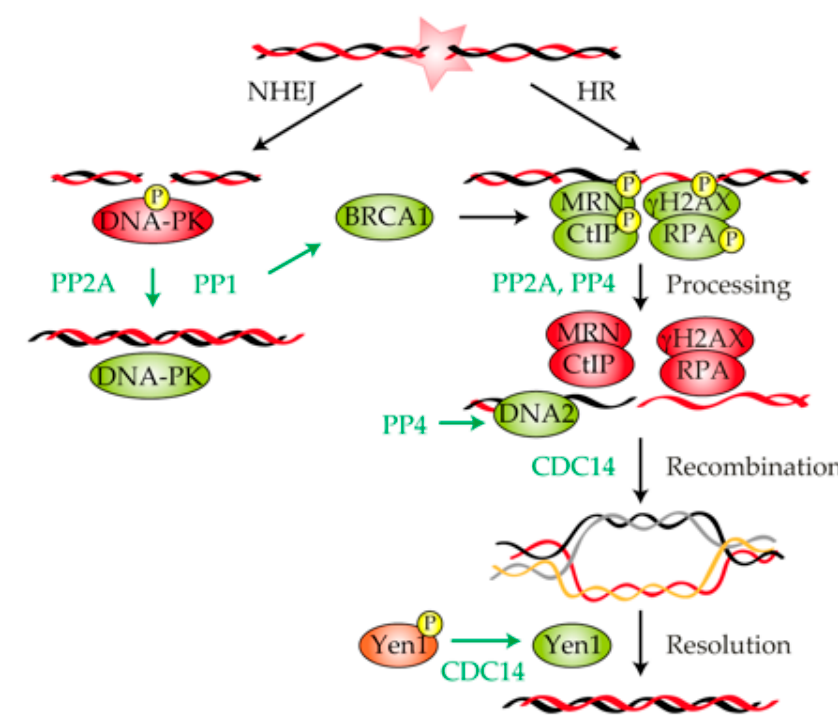
Figure 2. Involvement of protein phosphatases in the repair of a DNA lesion. Schematic representation showing the repair of a double-strand break (DSB) by non-homologous end joining (NHEJ) and homologous recombination (HR). Key factors involved in the execution of each repair pathway are shown. PP2A and PP1 stimulate NHEJ by dephosphorylating and activating DNA-protein kinase (PK). The dephosphorylation of MRE11–RAD50–NBS1 (MRN), γ -H2AX, CtIP and RPA by PP2A and PP4 is required for the processing and repair of the DNA lesion by HR. PP4 participates in HR by facilitating DNA2 accessibility to the DSB vicinity, thus enhancing DNA end resection. CDC14 promotes both recombinational DNA repair and resolution of recombinant intermediates. Green and red represent active or inactive,